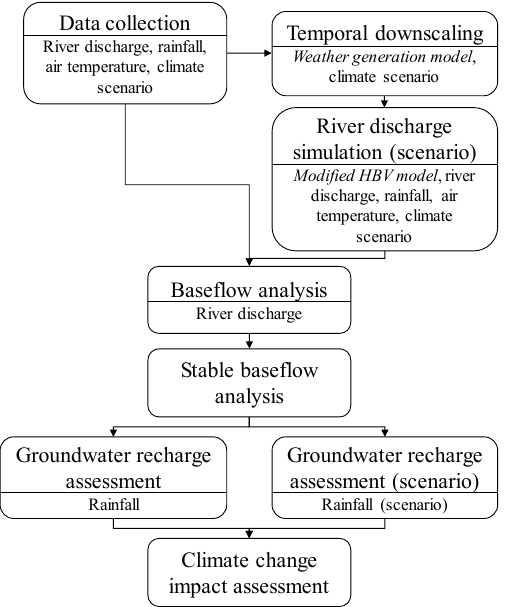
Figure 1. Flowchart used for the assessment of climate change impact on groundwater recharge.